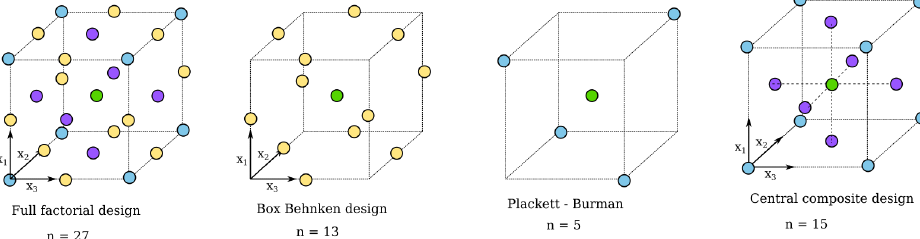
Figure 4. Illustration of the sampling points in the used design of experiment methodologies in the case of a three level, three parameter